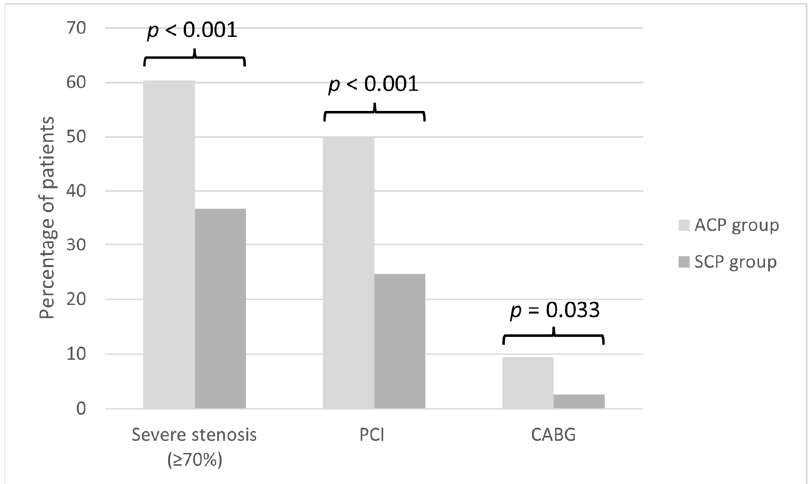
Figure 2. Rates of Severe stenosis, PCI and CABG stratified by the study groups. ACP: acute chest pain, CABG: coronary artery bypass grafting, PCI: percutaneous coronary intervention, SCP: stable chest